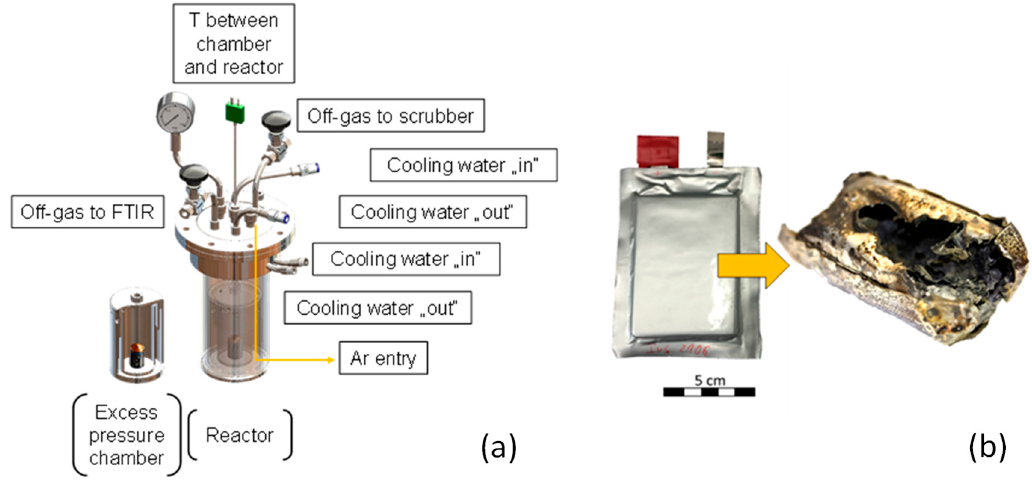
Figure 2. ( a ) Schematic pyrolysis set-up with relevant entries into and exits for gaseous and liquid components. ( b ) LSB cell from Fraunhofer IWS before and after pyrolysis.